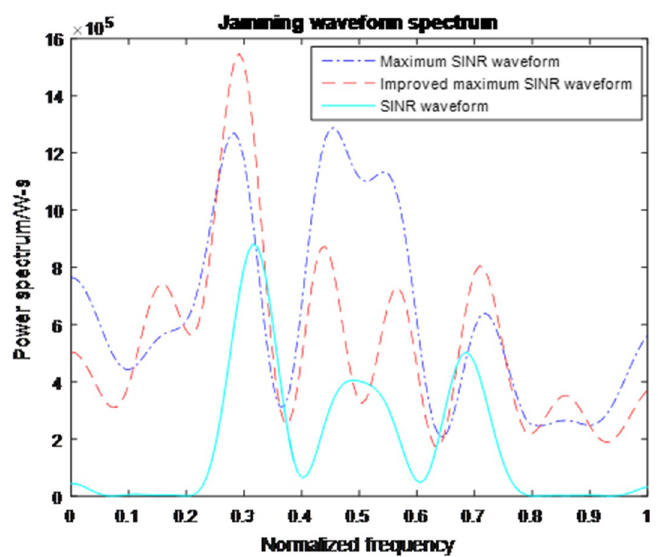
Fig. 7 Jamming waveform spectrum of jammer with maxmin